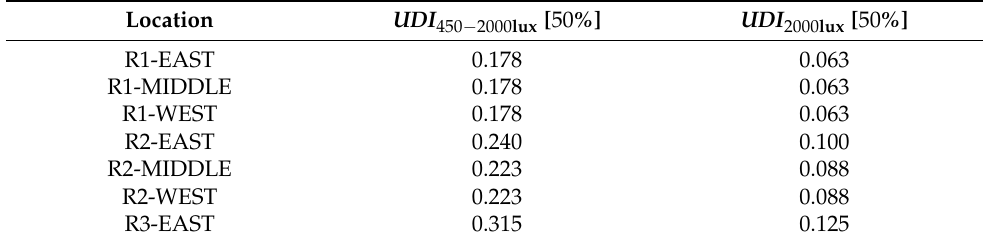
Table 5. Adjustment results of all reference sensor locations in the small office